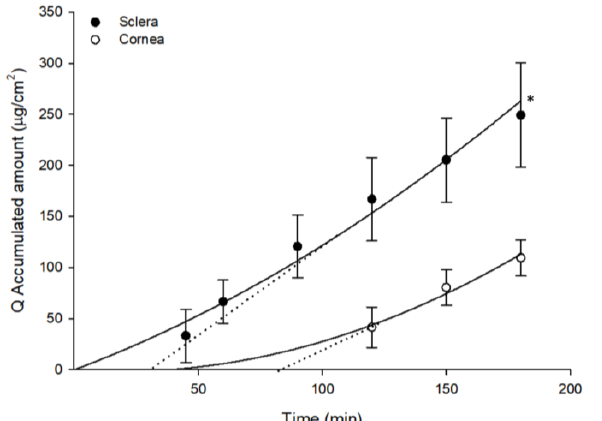
Figure 4. Accumulated amounts of GSH in the receptor compartment (Q, μg/cm 2 ) as a function of time, obtained from samples employed in ex-vivo trans-corneal and trans-scleral diffusion studies with the formulated insert. The dotted line represents the estimated lag time (t 0 ) calculated by intersecting with the x -axis of the linear regression. (Mean ± SD; n ≥ 3) * p < 0.05.